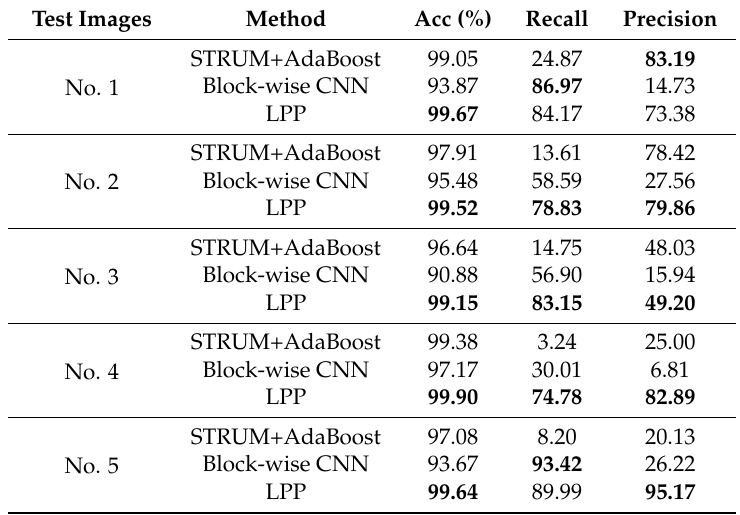
Table 1. Crack locating accuracy comparison (the best results are marked in